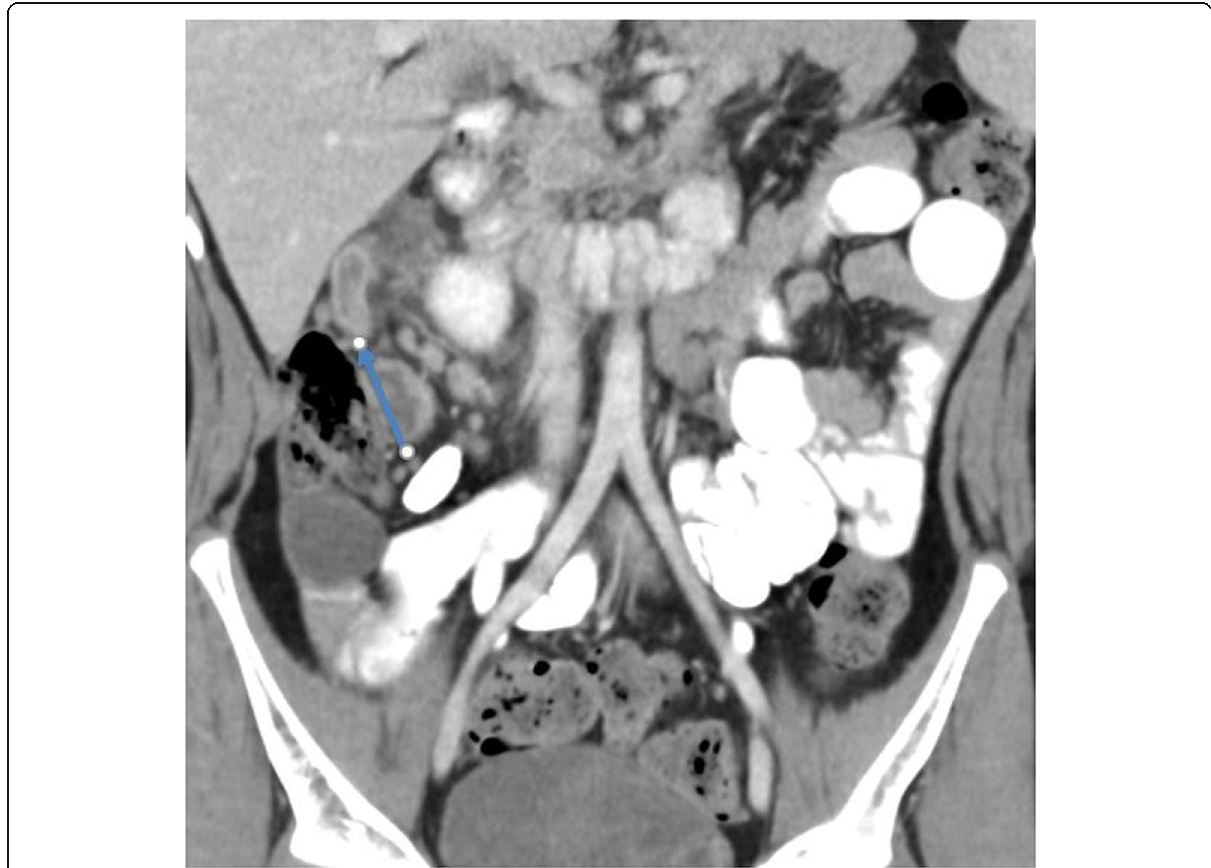
Fig. 4 Coronal abdomen CT image (appendicitis protocol) of an 11-year-old male (42 kg) acquired at 6 mGy. Acute appendicitis (arrow) and overall image quality scored optimal (score 3 or 4) by all